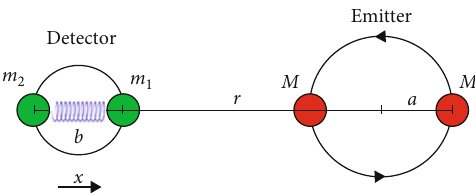
Figure 1: Simpli fi ed modelling of the periodic gravitational signal emitting device and the gravitational signal detector. Source: from the